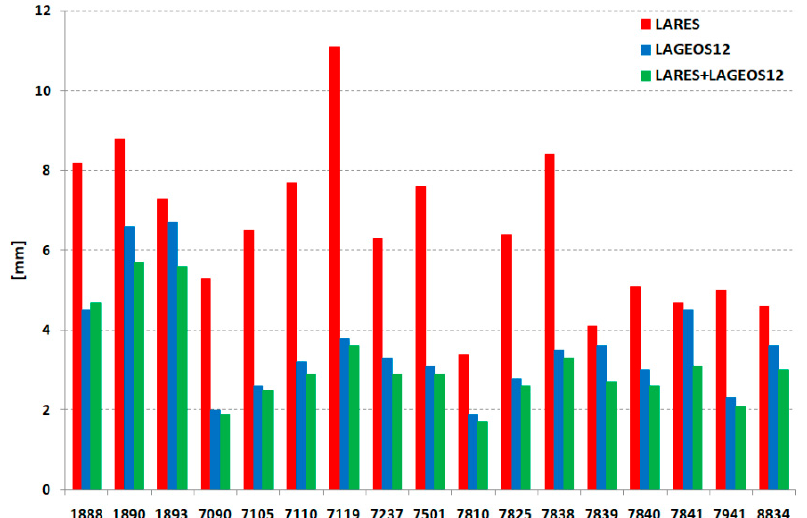
Figure 8. The average 3D precision for each station for three solutions: only LARES (red), LAGEOS-1 + LAGEOS-2 (blue), LARES + LAGEOS-1 + LAGEOS-2 (green). Examples of the determined North, East, and Up components for each arc for LAGEOS and LARES + LAGEOS for the Zimmerwald and Yarragadee stations are presented in Figures 9 and 10,